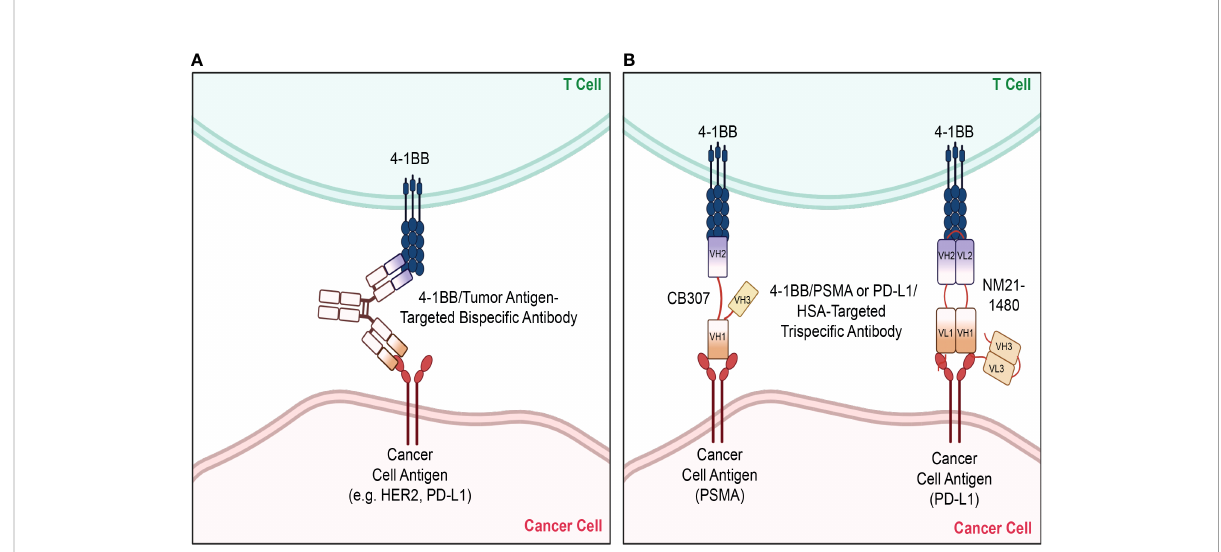
FIGURE 3 Bispeci fi cs and Trispeci fi cs used as therapeutic strategies. Various novel strategies have been implemented in targeting 4-1BB, with a primary focus on bispeci fi c and trispeci fi c antibodies. (A) The bispeci fi c antibodies mainly target 4-1BB and another tumor antigen upregulated on cancer cells, such as HER2 or PD-L1, to localize and limit 4-1BB stimulation to the tumor microenvironment. (B) Currently studied trispeci fi c antibodies are likewise composed of the variable regions of the individual antibodies targeting 4-1BB and the tumor antigen. A third variable region domain targeting HSA is attached to these domains, which serve the purpose of prolonging their serum half-lives. The trispeci fi c antibody CB307 is composed of the heavy chain variable domains of the antibodies targeting 4-1BB, PSMA, and HSA. The trispeci fi c antibody NM21-1480 is composed of both the light chain variable domains of the antibodies targeting 4-1BB, PD-L1, and HSA. HER2, human epidermal growth factor receptor 2; PD-L1, programmed cell death ligand-1; PSMA, prostate speci fi c membrane antigen; HSA, human serum albumin, VH, heavy chain variable domain; VL, light chain variable domain. The fi gure was created with